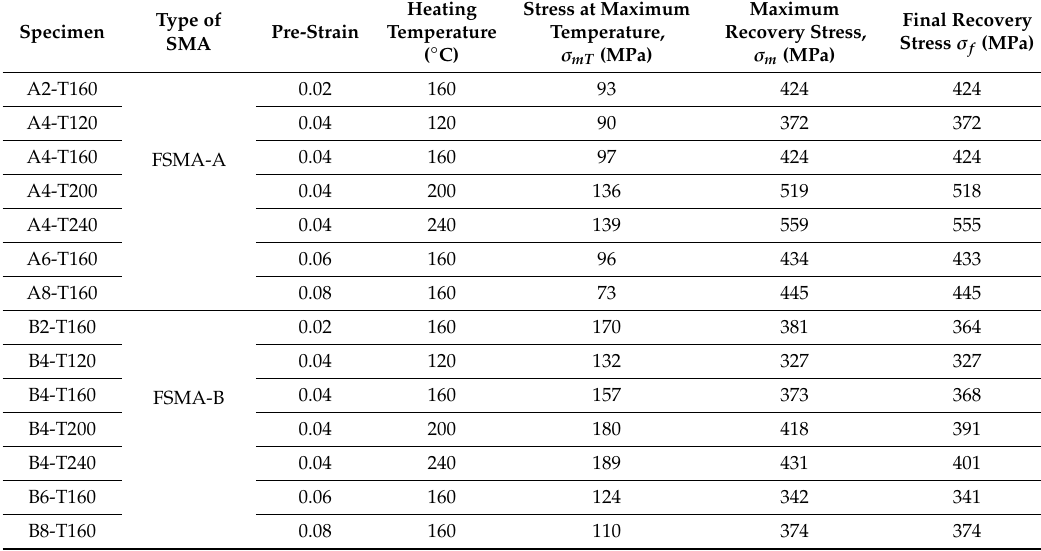
Table 2. Details of variable and summary of activation test result under rigid restraint.